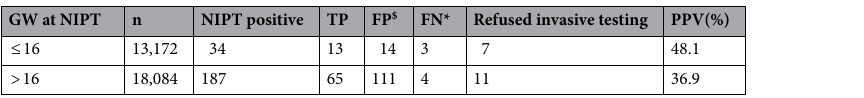
Table 3. The overall PPV and the rate of TP in each of these two cohorts (at ≤ 16 weeks and > 16 weeks). * ,$ 13 of 18 pregnancies who declined invasive testing with no confirmed test and 23 pregnancies that have been lost follow-up with low-risk results were excluded when making data statistics.